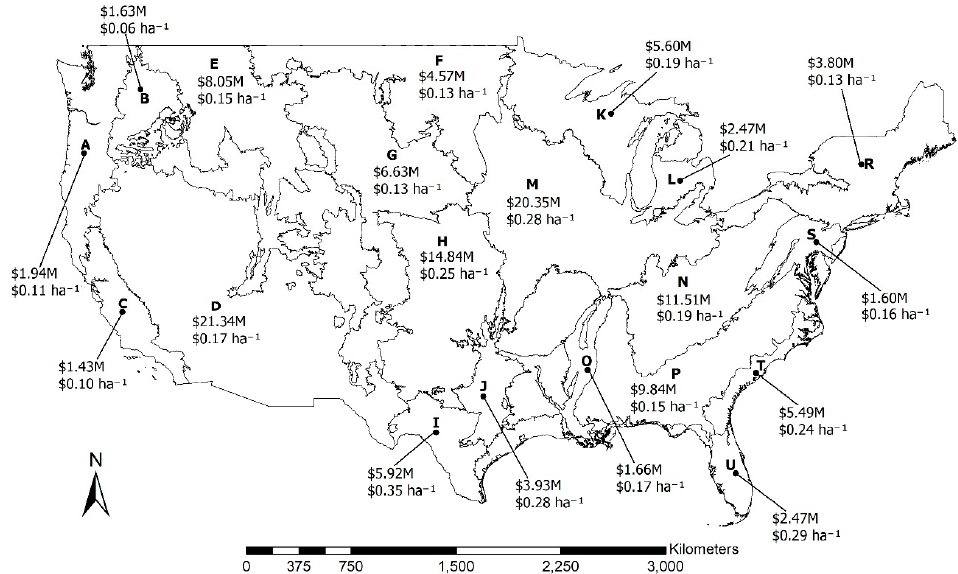
Figure 3. Average annual total ( top number ) and area-normalized ( bottom number ) monetary values of non-constrained potential soil inorganic carbon (SIC) sequestration from combined atmospheric Ca 2+ and Mg 2+ deposition (2000–2015) for different Land Resources Regions (LRRs) in the contiguous United States (U.S.) based on an avoided SC–CO 2 of $42 per metric ton of CO 2 [16]. Note: M = million = 10 6 .